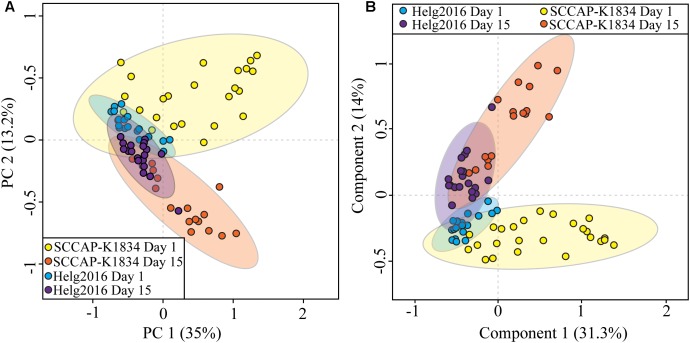
Statistical comparison of LSC-MS profiles of Coscinodiscus granii strain SCCAP-K1834 and isolate Helg2016 recovered from early (Day 1) and late (Day 15) growth stages. (A) PCA score plot (B) PLS-DA score plots displaying dissimilarities between LSC-MS profiles of young (day 1 early exponential growth phase) and old (day 15 early stationary growth phase) cells of C. granii. The LSC-MS profiles of both strains are included in the analysis. The ellipses represented the 95% confidence region estimated by the statistical calculation.